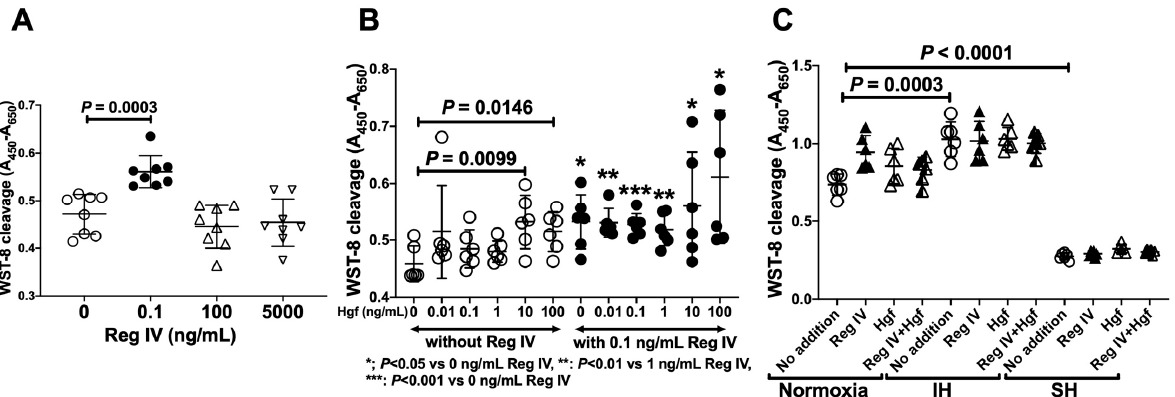
Figure 4. Cardiomyocyte proliferation by Reg IV and Hgf. ( A ) Mouse recombinant Reg IV (0–5000 ng/mL) was added to a differentiated mouse P19.CL6 cardiomyocyte culture medium in SH condition, and cell numbers were measured by WST-8 assay. Open circles, closed circles, upward open triangles, and downward pointing open triangles indicate WST-8 values of the cells in the addition of 0, 0.1, 100, and 5000 ng/mL Reg IV, respectively. ( B ) Hgf (0–100 ng/mL) was added in a differentiated mouse P19.CL6 cell culture medium, and the cells were incubated for 24 h in SH condition. Viable cell numbers were measured by a WST-8 assay. ( C ) The cells were incubated in normoxia, IH, or SH in the presence/absence of Reg IV (0.1 ng/mL) and/or Hgf (0.1 ng/mL) for 24 h. Viable cell numbers were measured by a WST-8 assay. Data are expressed as mean ± SD for each group. The statistical analyses were performed using Student’s t